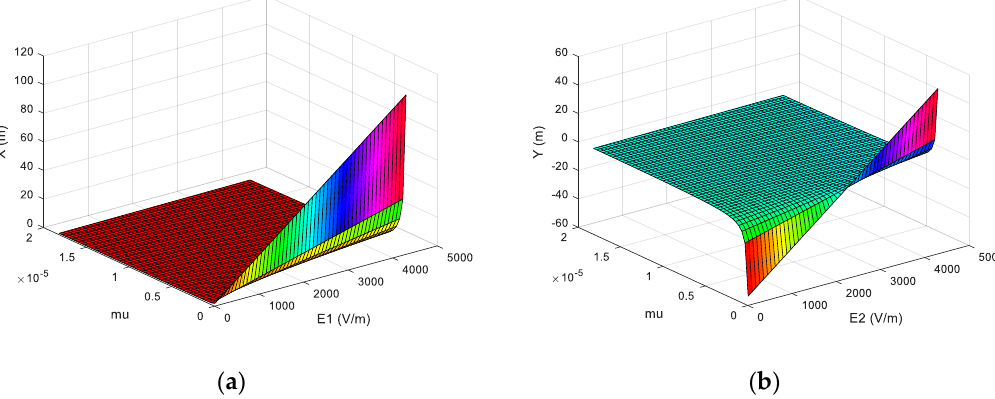
Figure 13. Dynamic displacement response of PM 50 under the combined action of drag and electric field: ( a ) X -axis displacement; ( b ) Y -axis displacement.